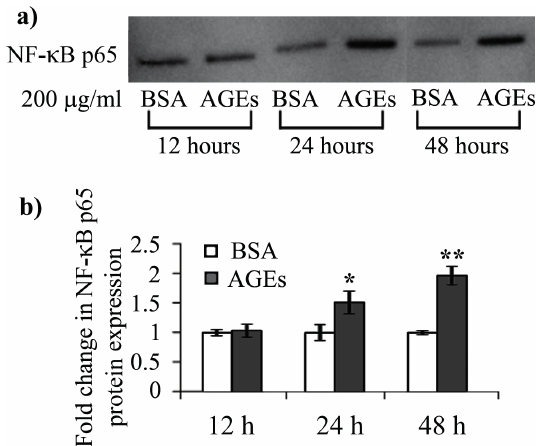
Figure 1. NF- κ B p65 protein expression levels ( a ) Representative immunoblot membrane; ( b ) Combined densitometry data of three individual experiments, indicating fold changes